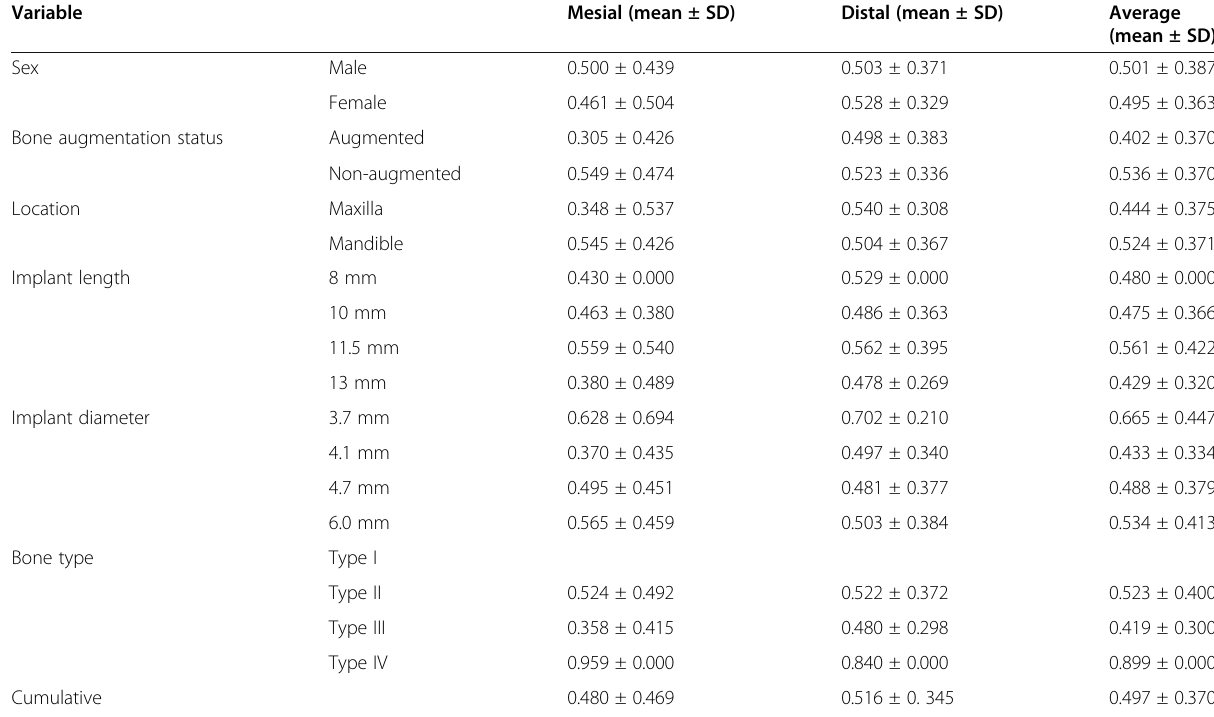
Table 8 Bone loss at 7 years based on study variables Variable